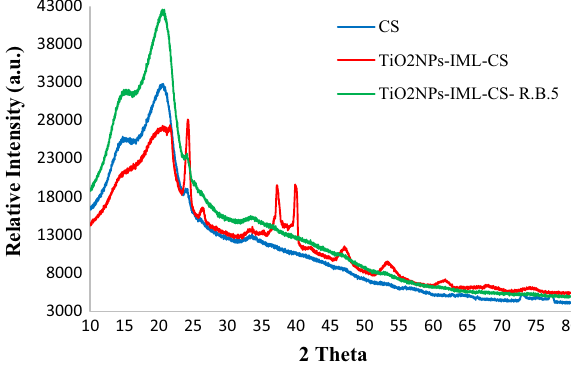
2 NPs; TiO 2 NPs-IML-CS and